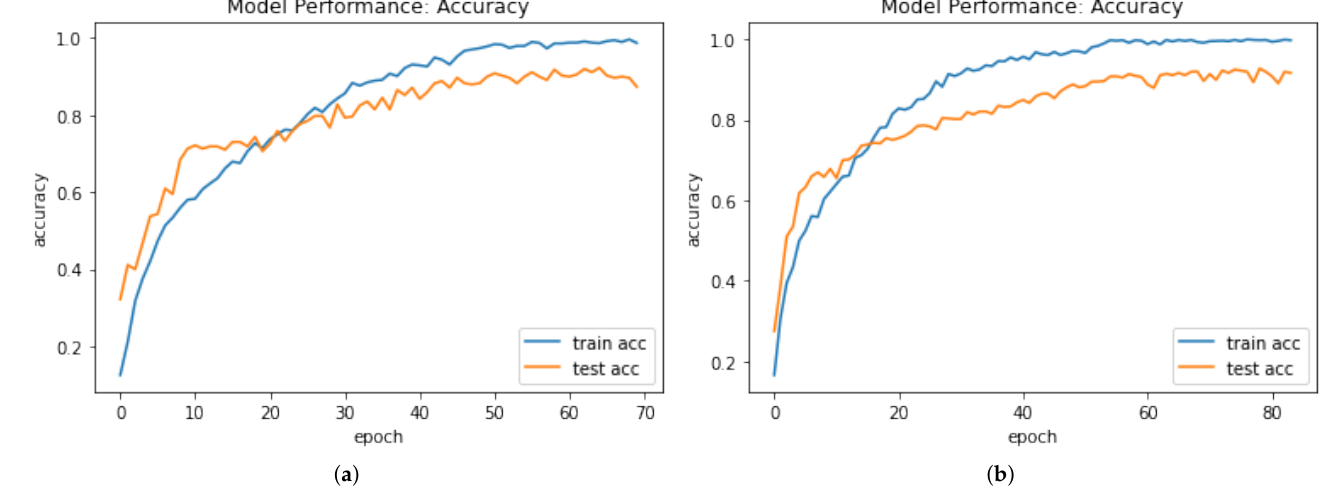
Figure 11. Accuracy-performance graph for ( a ) Model 1 and ( b ) Model 2.